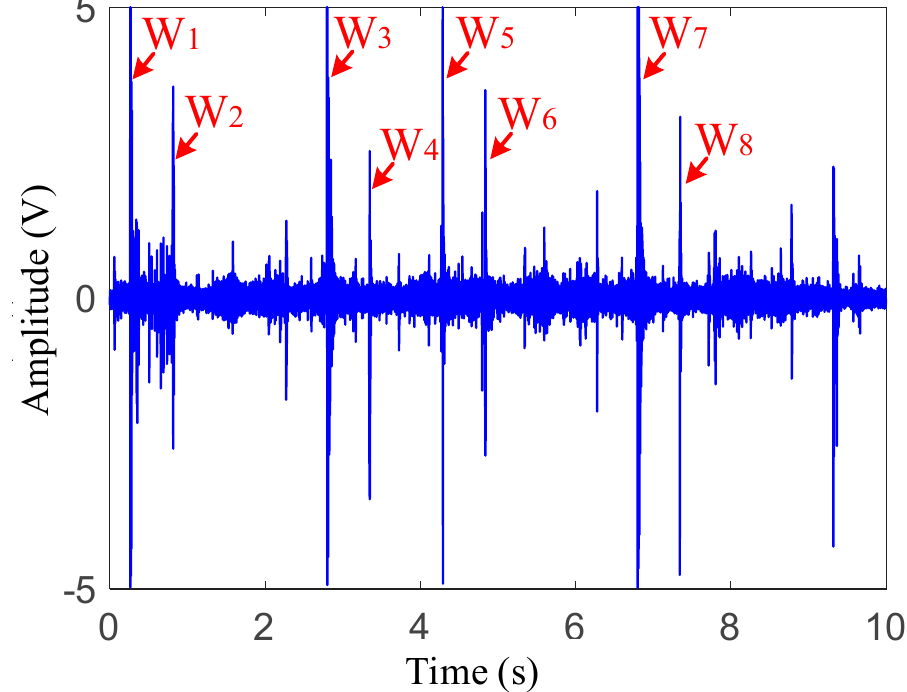
Figure 5. The ( a ) diagram and ( b ) figure of the experimental system.